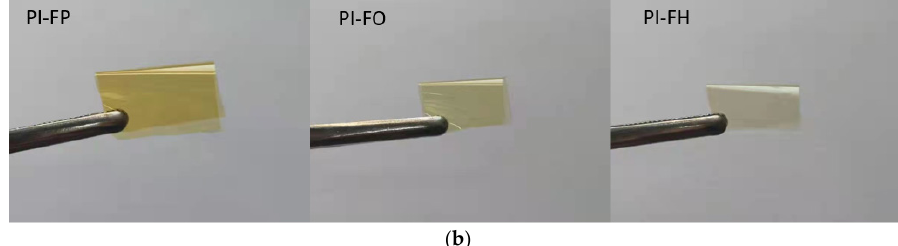
Figure 1. The synthesis procedure for PPA ( a ) and the photos of the PI films ( b ).